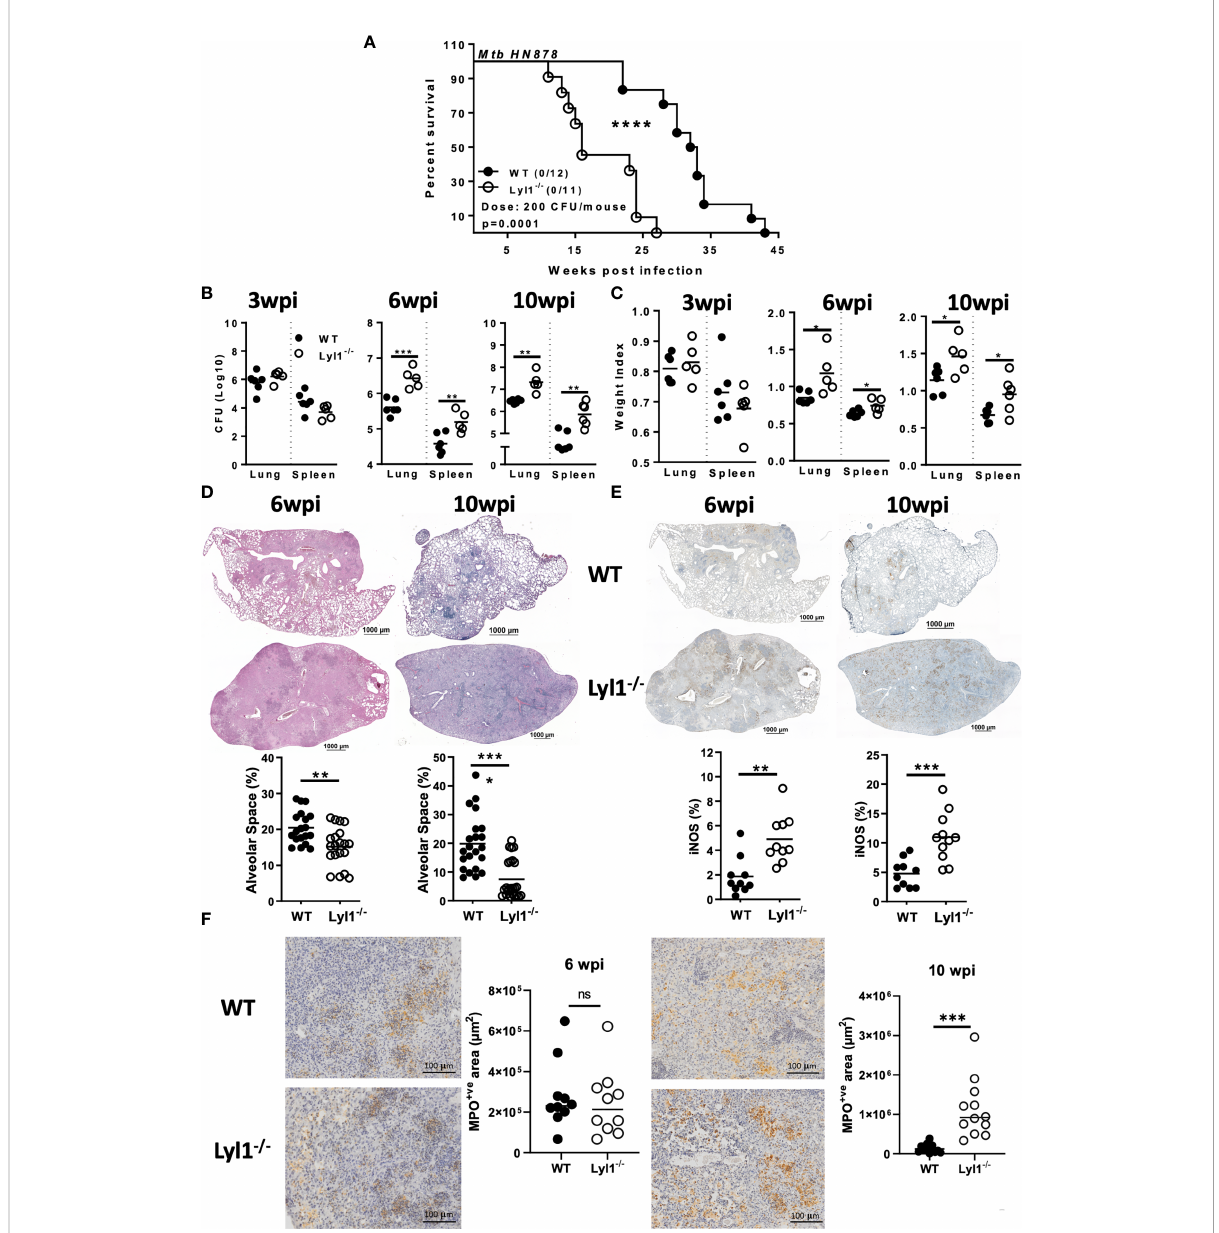
FIGURE 4 Lyl1 deletion renders mice more susceptible to Mtb HN878 infection with increasing lung and spleen bacterial burden. (A) Survival study by intranasally administering Mtb HN878 at 200 CFU/mouse (n = 11-12 mice/group). Mantel-Cox survival analysis is performed with log-rank test P = 0.0001. (B-E) Littermate control (WT) and Lyl1 -/- mice were infected with ~100 CFU/mouse intranasally with Mtb HN878 (n = 5-6 mice/ group) and sacri fi ced at 3-, 6- or 10- weeks post-infection to determine (B) lung and spleen CFU burden as well as (C) lung and spleen weight index. (D) Representative lung histopathology sections (x20 magni fi cation) for H&E (scale bar = 1000µm) with quanti fi ed alveolar spaces from 4 deep cut lung sections per mouse (30µm apart). Each plot represents lung sections that are free from cells (%) and thus indicative of alveolar space. (E) Representative iNOS immunohistochemistry lung section (x10 magni fi cation) with quanti fi ed iNOS positive areas from two deep cut lung sections per mouse (30µm apart). (F) Representative myeloperoxidase (MPO) immunohistochemistry lung section (x40 magni fi cation) with quanti fi ed MPO positive areas from two deep cut lung sections per mouse (30µm apart). Line denotes Mean. Data shown are representative of 2-3 independent experiments. Unpaired student t-test analysis at *p < 0.05, **p < 0.01, ***p < 0.001, ****p < 0.0001 to determine signi fi cance, ns, not signi fi